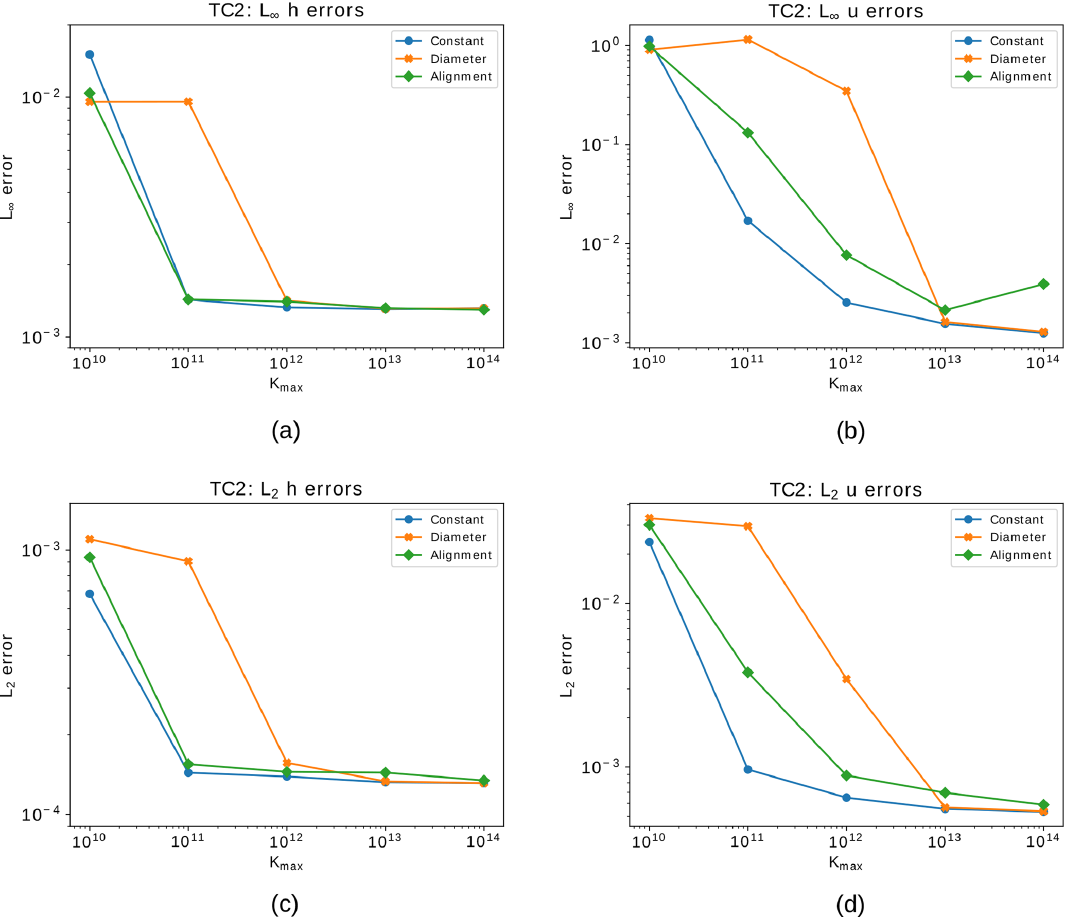
Figure 7. Steady geostrophic flow test case showing relative errors after 30d for the VR6 grid using the different hyperdiffusion methods and different values of K max . (a) L ∞ error for the height field. (b) L ∞ error for the normal component of the velocity field. (c) L 2 error for the height field. (d) L 2 error for the normal component of the velocity field. The blue lines consider a constant hyperdiffusion coefficient, the orange lines consider an alignment-based coefficient and green lines consider a diameter-based coefficient.